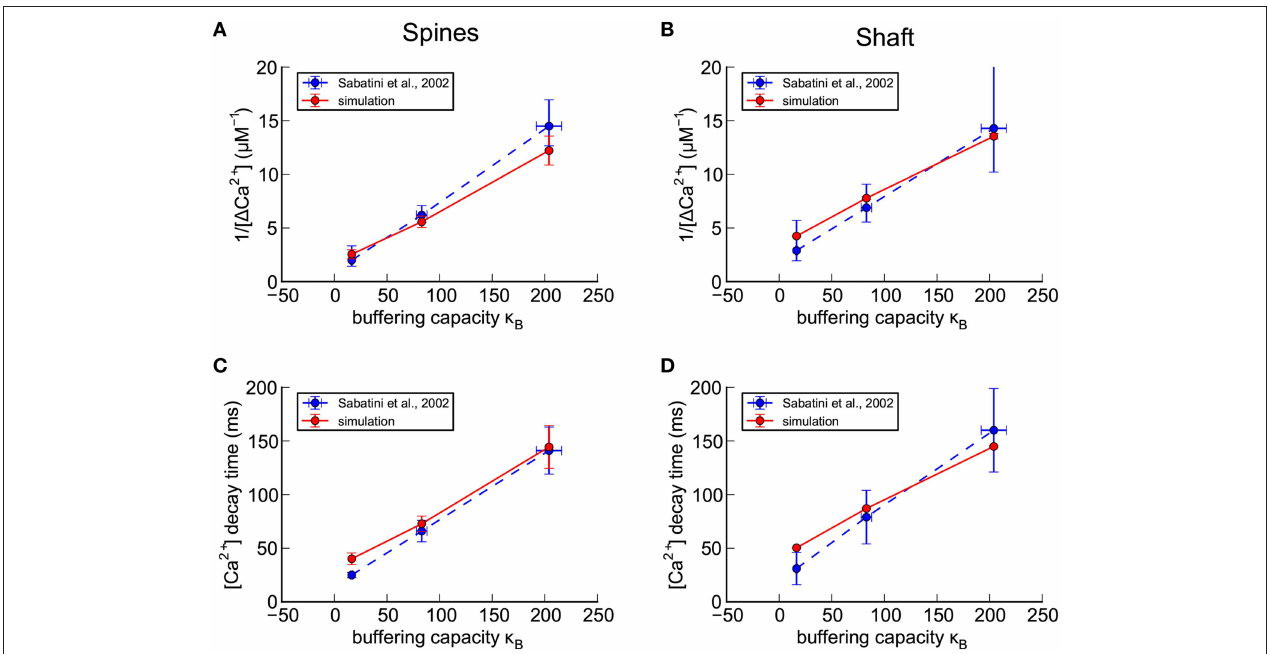
FIGURE 5 | Calibration of nine parameters in spines and shafts of the small branch spine. (A–D) Confirmation of calibration of the shape of a Ca 2 + transient in response to a bAP in the absence of calbindin (see Methods Section). For comparison with experimental results of Sabatini et al. (2002; shown as blue dashed lines), concentrations of exogenous fluorescent calcium indicators in the model were set to 20 µ M Fluo4, 50 µ M OGB1, or 100 µ M OGB1. The simulated results for the best calibrated parameters, averaged for seven spines with volumes ≥ 0.05 fl, are shown as red lines. (A) For each concentration of indicator, the reciprocal of the averaged peaks of the calcium transients in the spines, 1/ 1 [Ca 2 + ], is plotted against the buffering capacity in the presence of indicator ( κ B ) calculated as in Sabatini et al. (2002) . The 1 [Ca 2 + ], extrapolated to zero indicator, was in the range 0.5 to 1.0 µ M (reciprocal of y-axis intercept) with κ e in the range 16–50 (x-axis intercept). (B) The reciprocal of the averaged peaks of the calcium transients in the dendritic shaft is plotted against buffering capacity. The 1 [Ca 2 + ], extrapolated to zero indicator, was 0.3 µ M with κ e = 62 . (C) The averaged time constant of calcium decay in the spines is plotted against calcium buffering capacity. The calcium decay time constant, extrapolated to zero indicator in the spines was in the range 20–40ms (y-axis intercept) with κ e in the range 30–80 (x-axis intercept). (D) The averaged time constant of calcium decay in the dendritic shafts was plotted against buffering capacity. The calcium decay time constant, extrapolated to zero indicator in the dendritic shafts was 42ms with κ e = 75